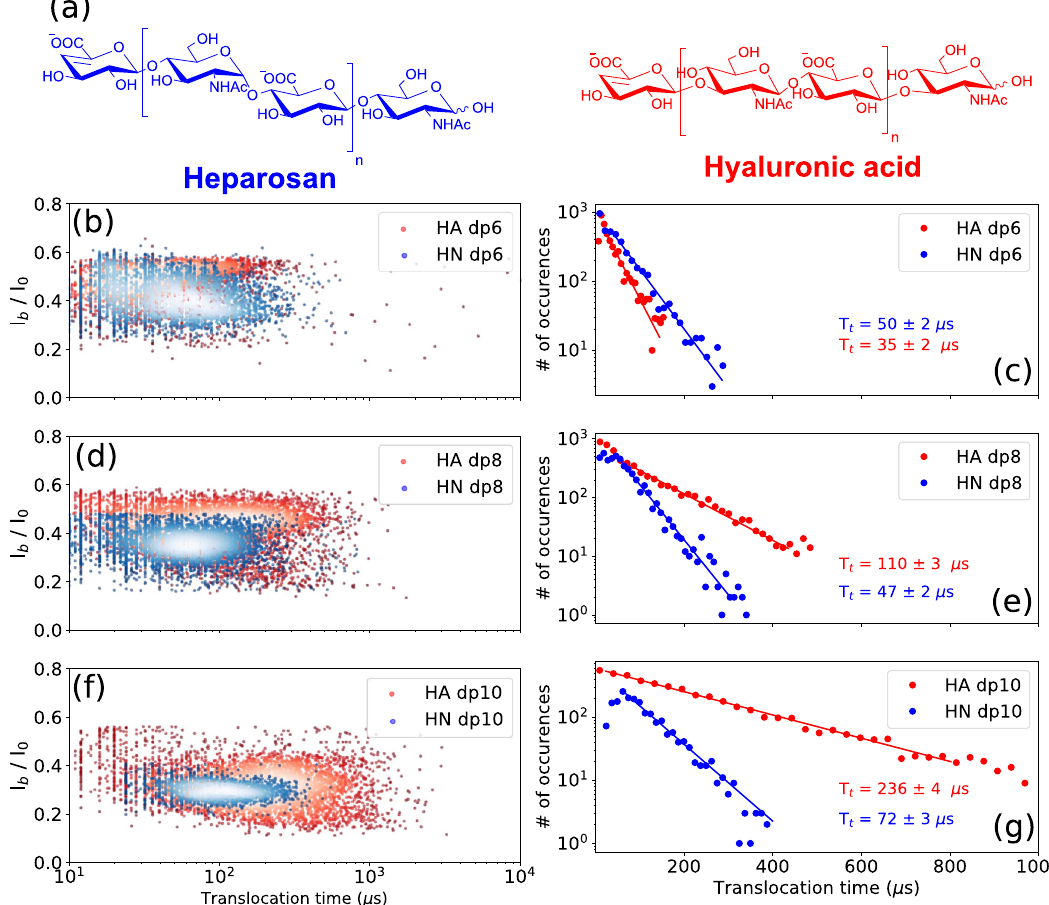
Fig. 5 | Effect of the osidic bond on the translocation behavior of the GAGs. a Structuresoftheheparosan(HN)andhyaluronicacid(HA).Superimposedscatter plots of the b HA dp6 and HN dp6, d HA dp8 and HN dp8, and f HA dp10 and HN dp10.Superimposed T t histograms of the c HAdp6 and HNdp6, e HAdp8 and HN dp8, and g HA dp10 and HN dp10. A noticeable difference in translocation time is observed between HAand HNoligosaccharides.HAoligosaccharidesshowa much